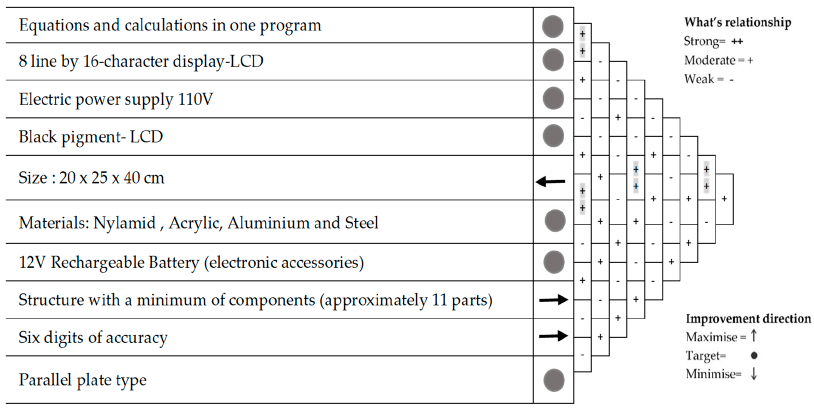
Figure 3. Technical or engineering requirements.